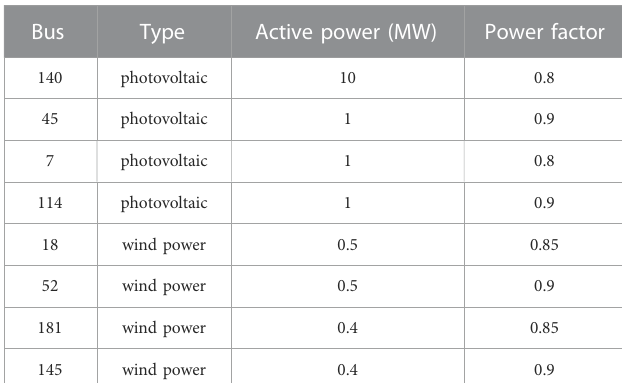
TABLE 7 DG Con fi